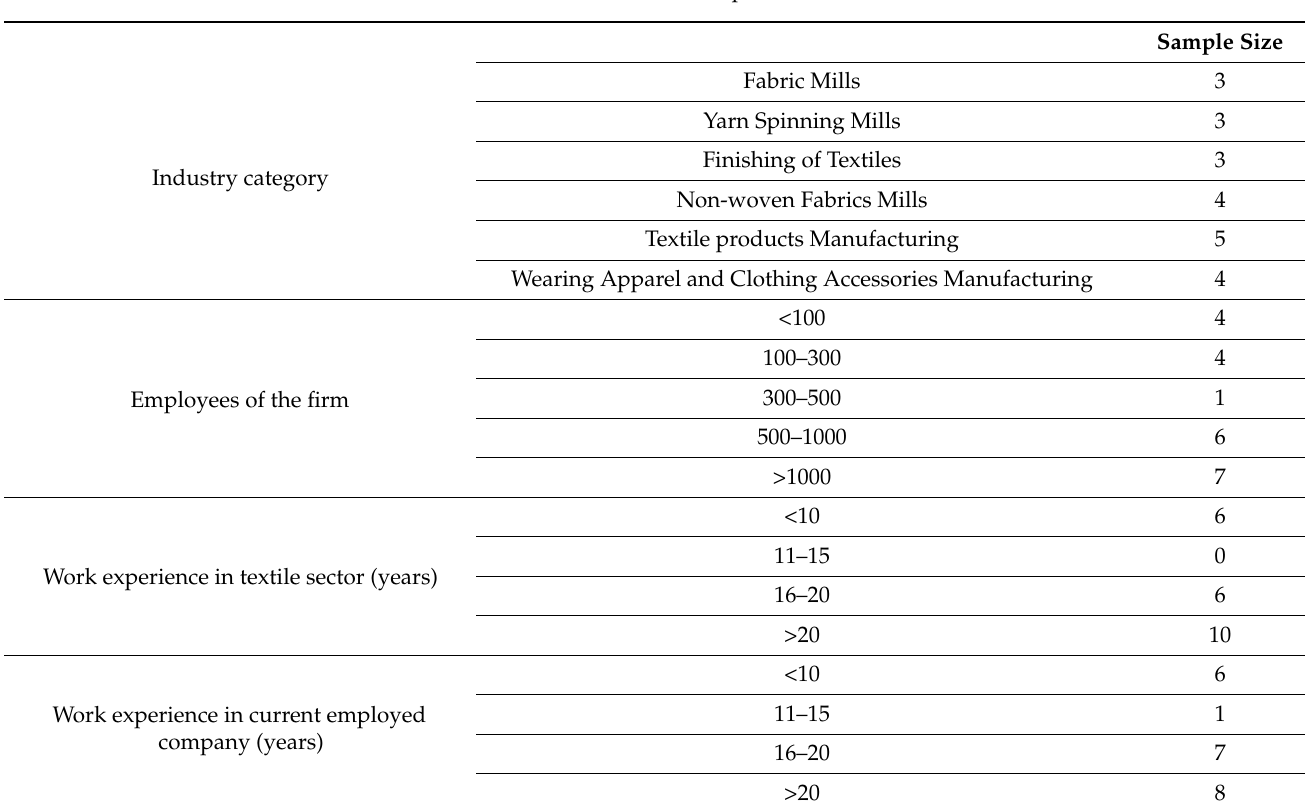
Table 2. Profile of